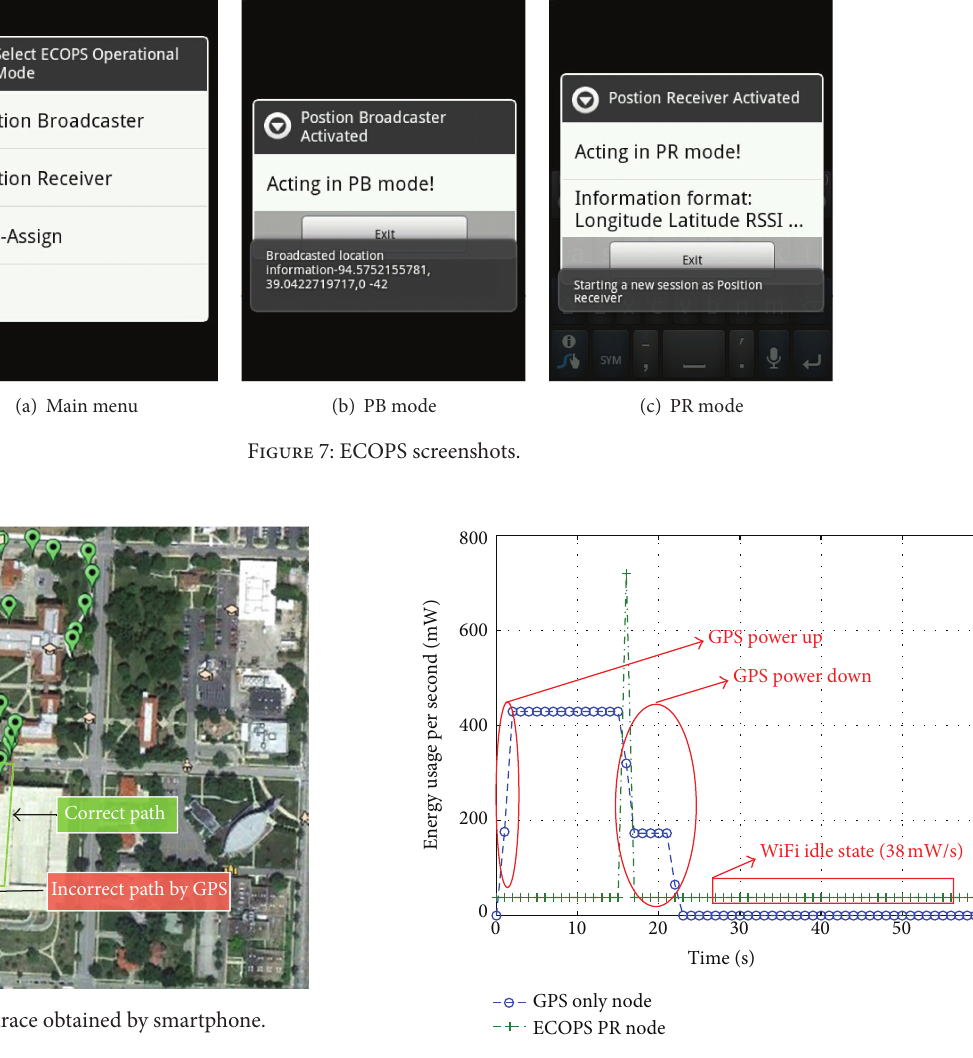
Figure 9: Energy usage: GPS versus ECOPS